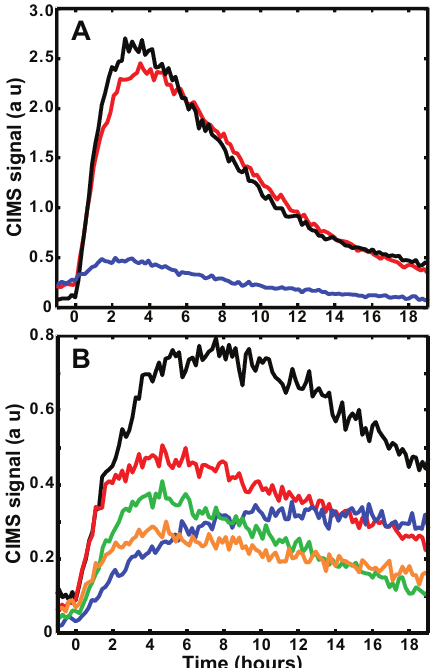
Fig. 3. CIMS time traces of a number of important low-NO x photooxidation products of α -pinene. (A ) Main first generation products, m/z ( − )271 α -pinene hydroxy hydroperoxide (black), m/z (+)169 pinonaldehyde (red), m/z ( − )253 α -pinene hydroperox- ide (blue) (B) Signals of species that are formed in multiple gener- ations m/z ( − )285 (black), m/z ( − )269 (red), m/z ( − )303 (green), m/z ( − )301 (orange), and purely second-generation m/z ( − )203 pinonic acid (blue). The signal from m/z (+)169 is the only signal shown from the positive mode and the intensity was divided by 2 for